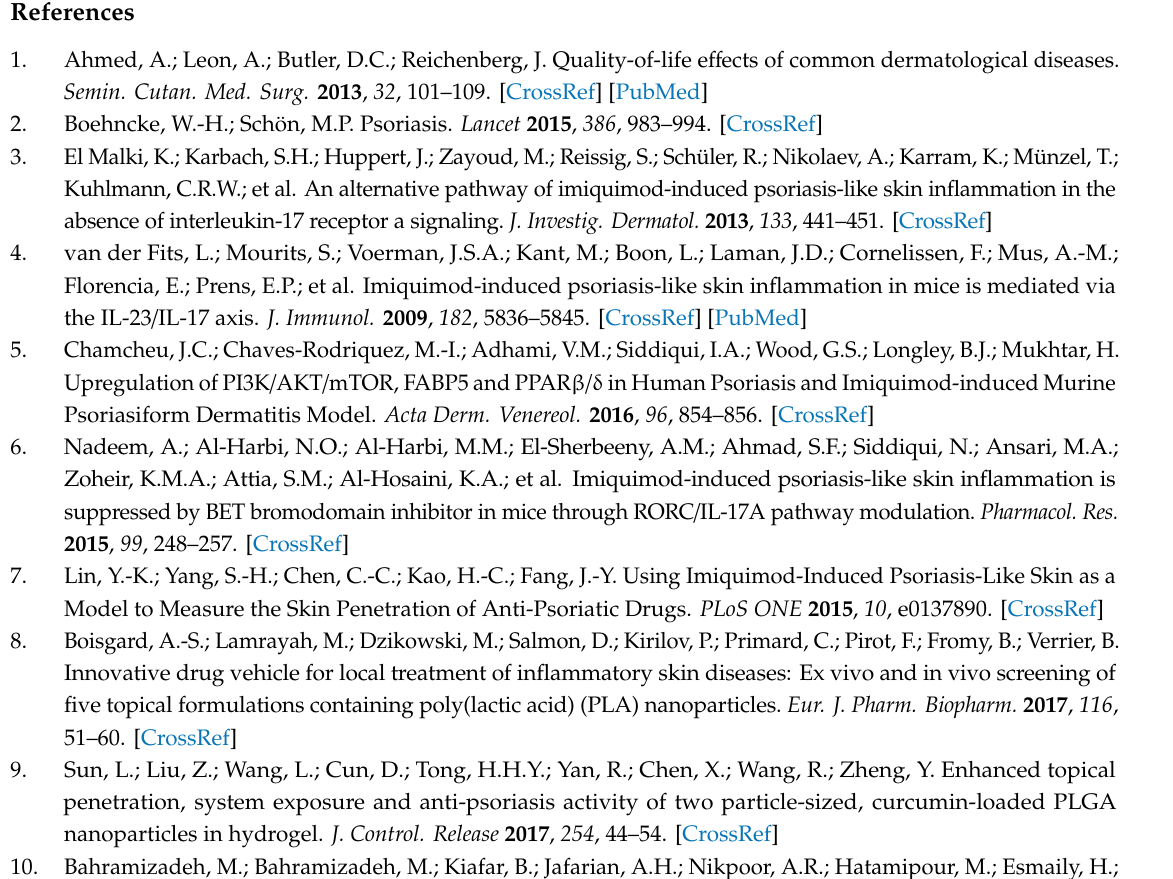
Figure S1: Measurement of back skin perfusion for 8 days with daily IMQ application. Figure S2: Loss of psoriasis-like phenotype after day 8. Figure S3. Application of the IMQ-induced psoriasis mouse model previously characterized as a tool to assess anti-psoriatic treatment e ffi